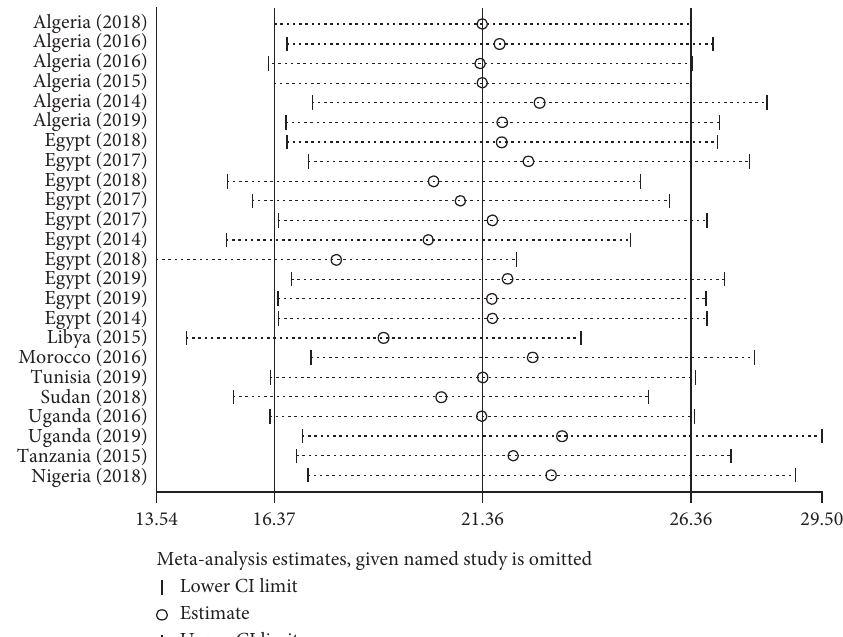
Figure 5: Sensitivity analysis for the pooled prevalence of CPPA in Africa from 2007 to 2018 G.C. Funnel plot with pseudo 95% confidence limits